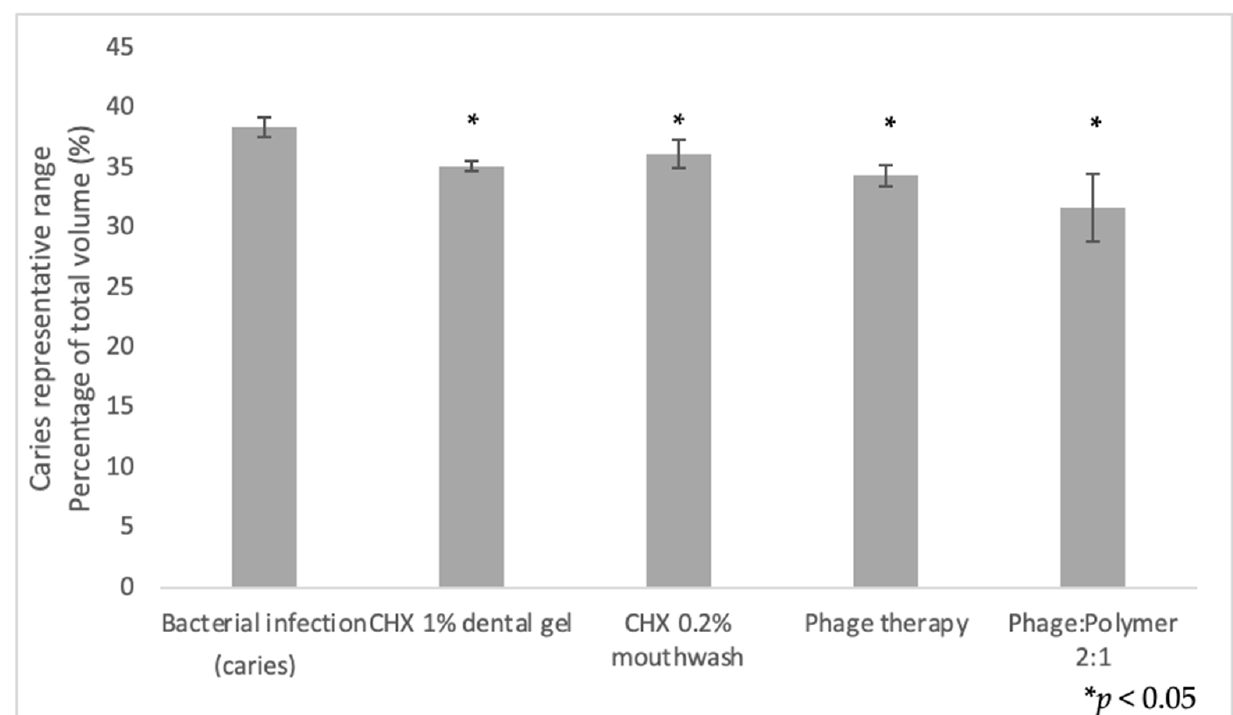
Figure 4. Quantification of demineralization. µ CT analysis comparison of volumetric percentage in caries representative range (500–1500 mgHA/ccm) after the experimental period. 100% = total crown volume. A significant decrease ( p < 0.05) in the caries density range was observed in all treatment groups compared to the untreated group infected with bacteria. Results are shown as mean ± SD based on five independent biological replicates.